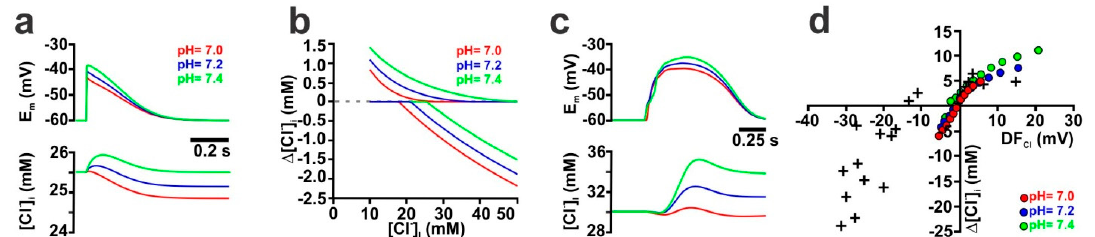
Figure 8. Influence of pH on GABA-induced membrane depolarization and [Cl ⁻ ] i transients. ( a ) Time course of E m and [Cl ⁻ ] i upon a single synaptic stimulation (g GABA = 7.89 nS, τ = 37 ms, P HCO3 = 0.18, initial [Cl ⁻ ] i = 30